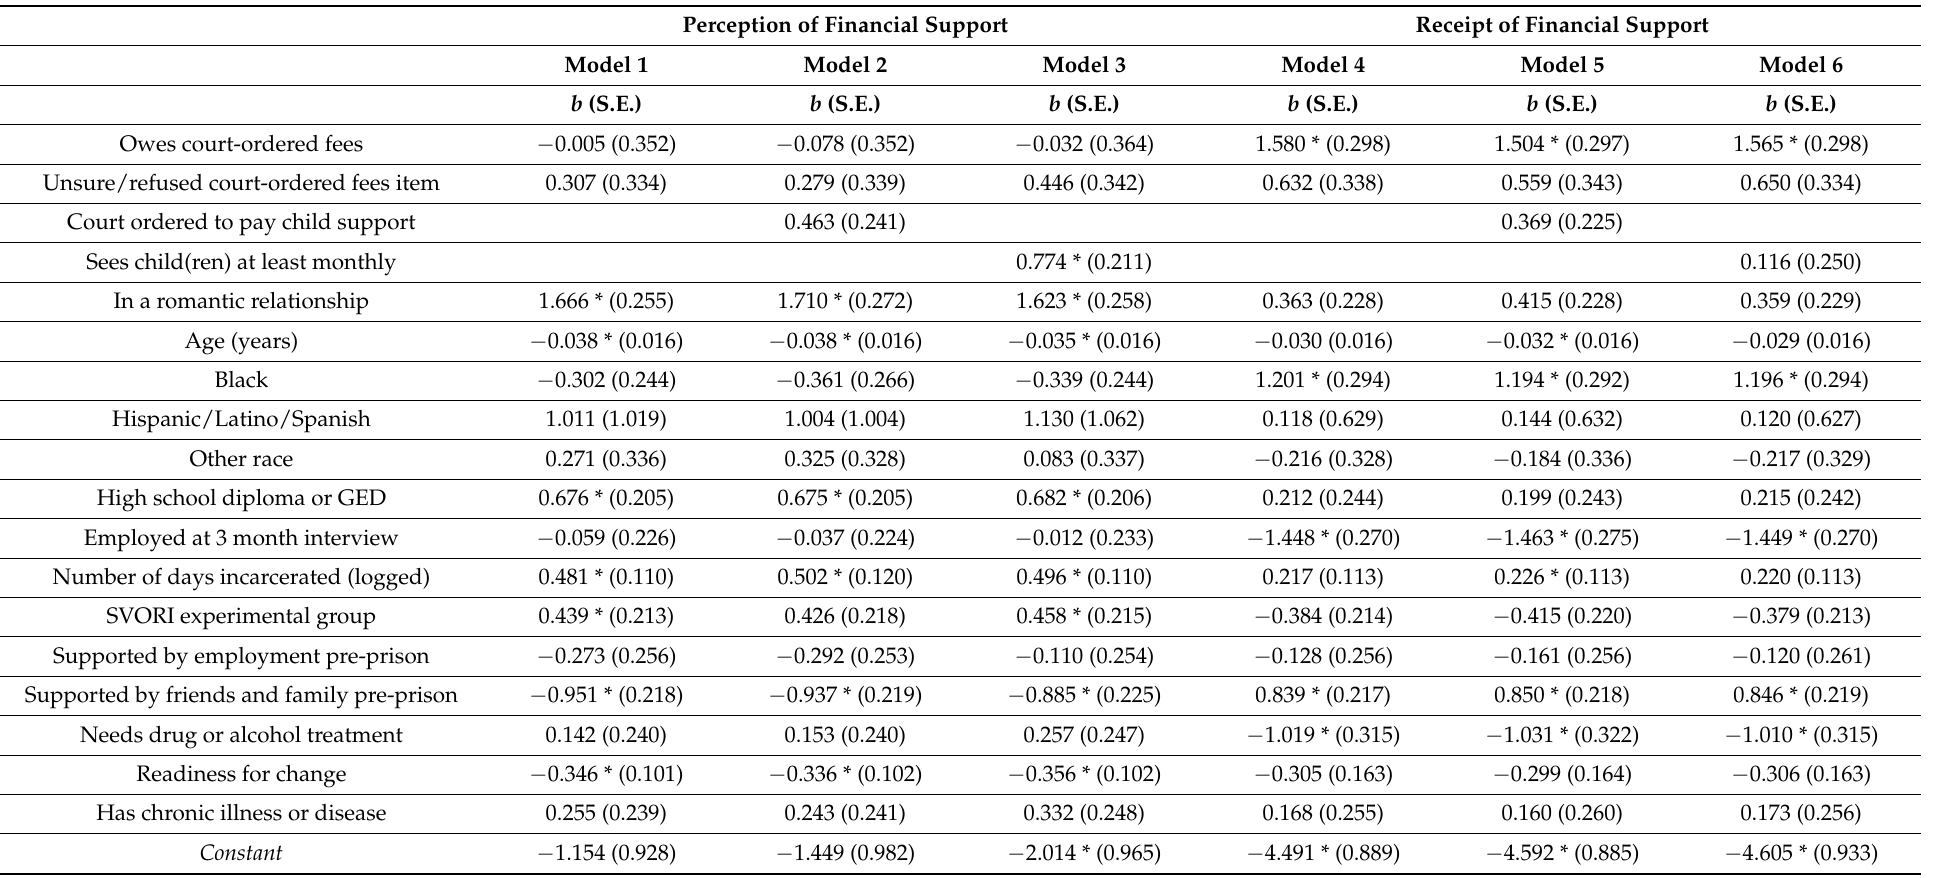
Table 2. Logistic Regression Models Predicting Perception of Financial Support and Receipt of Financial Support ( n =